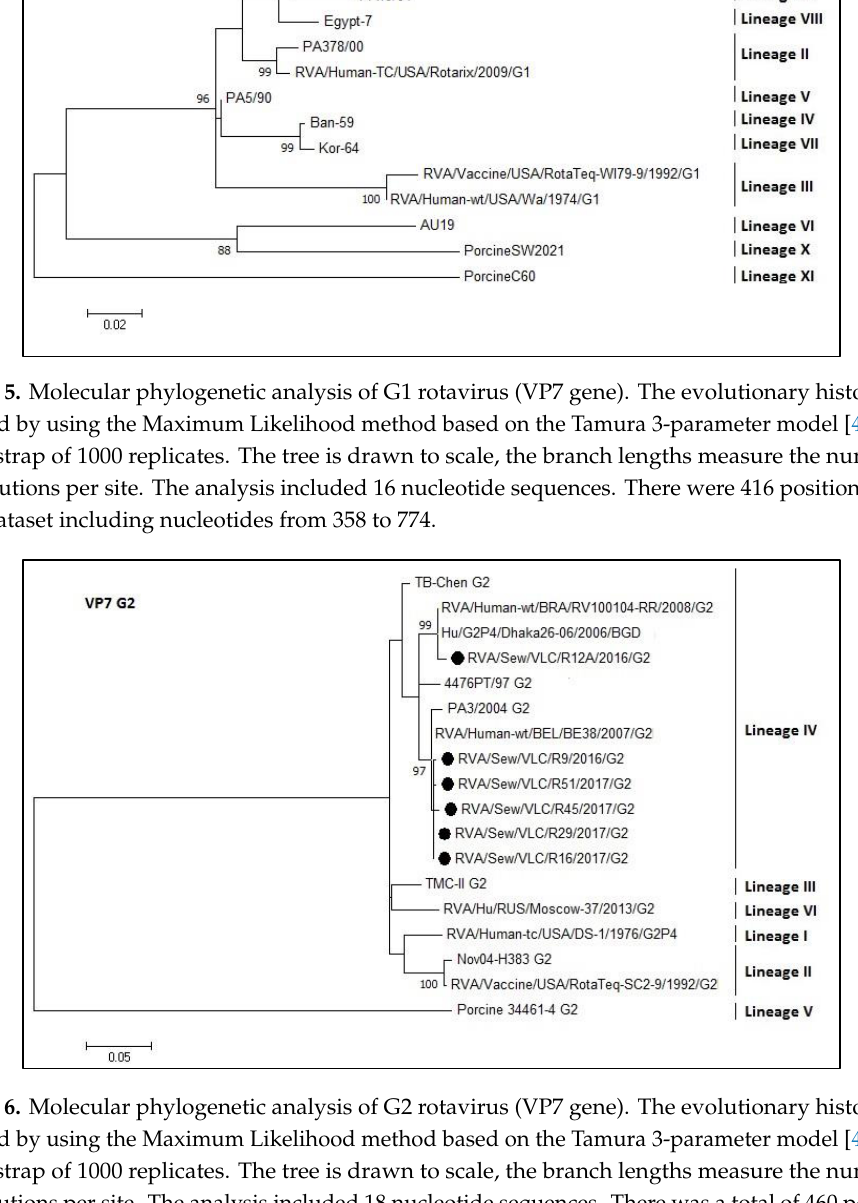
Figure 6. Molecular phylogenetic analysis of G2 rotavirus (VP7 gene). The evolutionary history was inferred by using the Maximum Likelihood method based on the Tamura 3-parameter model [43] with a bootstrap of 1000 replicates. The tree is drawn to scale, the branch lengths measure the number of substitutions per site. The analysis included 18 nucleotide sequences. There was a total of 460 positions in the final dataset including nucleotides from 424 to 884.